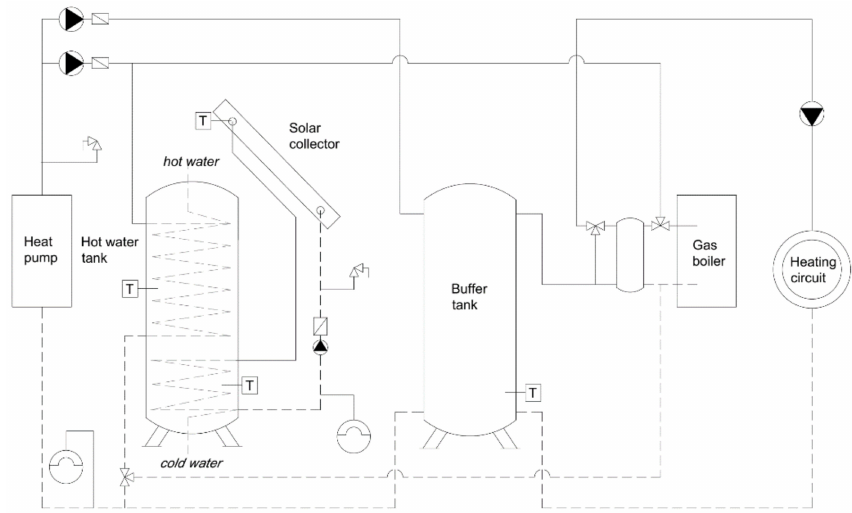
Figure 5. Hydraulic diagram of calculation Variant 2.